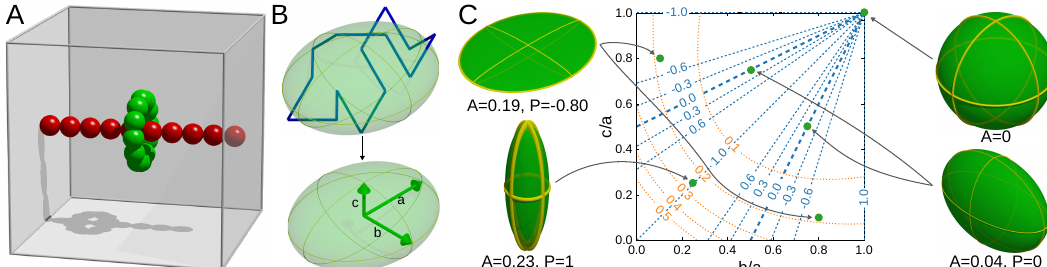
Figure 2. Description of the model and shape parameters. ( A ) The schematic presentation of the model used in the simulation–the shape of the freely moving green loop was analyzed; ( B ) The polymer with its ellipsoid of inertia (top) and the semi-axis of the ellipsoid used to calculate the shape parameters (bottom); ( C ) The exemplary ellipsoids with their location on the contour plot of the asphericity (orange curves) and prolateness (blue curves) in the space of the fraction of ellipsoid semi-axes a > b > c . Note that for spherical ellipsoid ( b / a = c / a = 1), the prolateness is